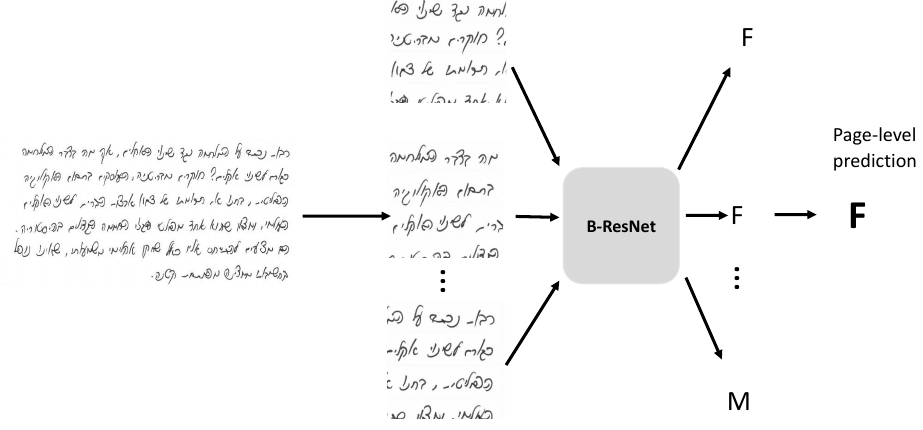
Figure 3. The pipeline of the classification procedure. F and M stand for female and male, respectively. The input image contains Hebrew